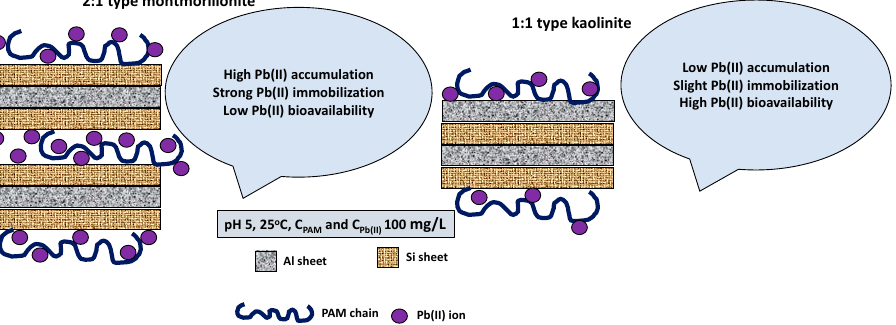
Figure 4. The schematic representation of effect of mineral type on the binding mechanisms of both adsorbates (for example, AnPAM-30 and Pb(II)) on the aluminosilicate surface; pH 5, initial concentration of adsorbates is 100 mg/L.